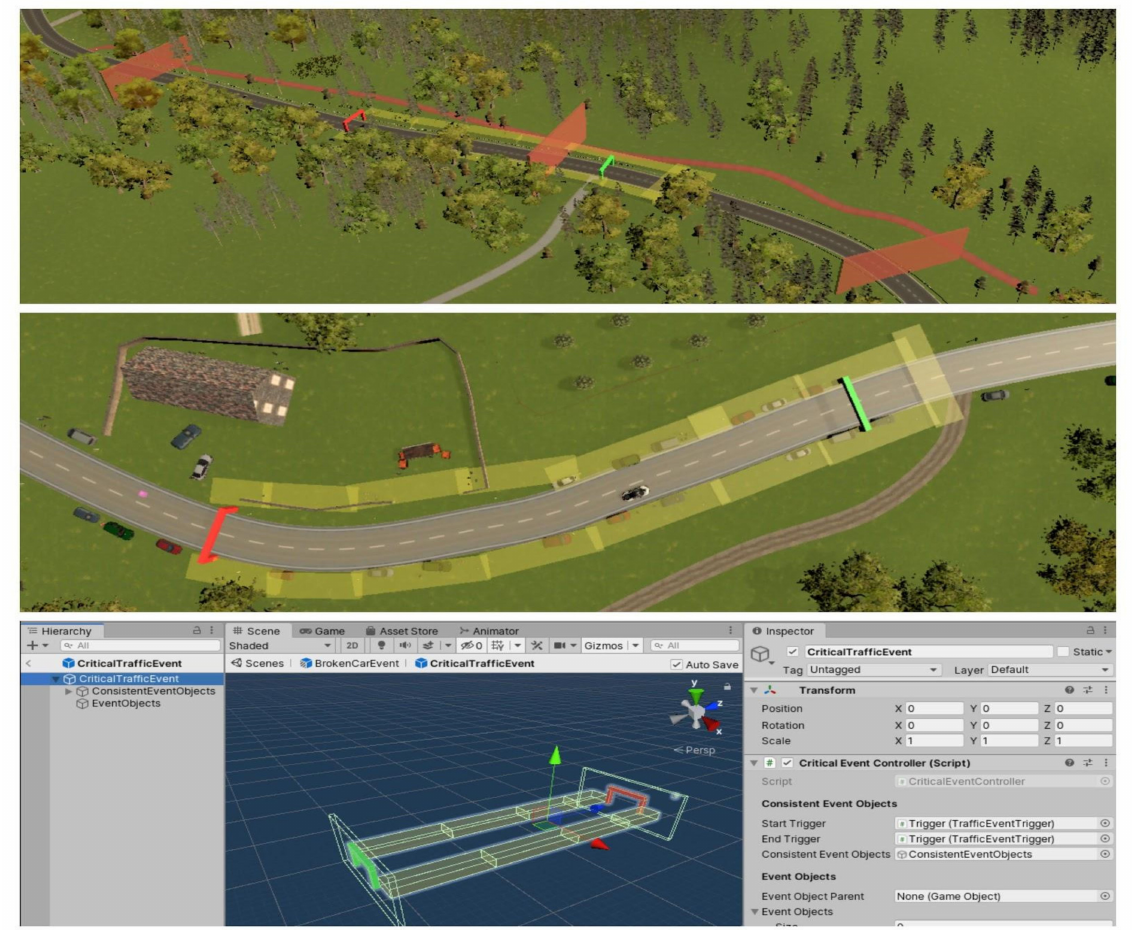
Figure 4. Critical traffic event prefab and its